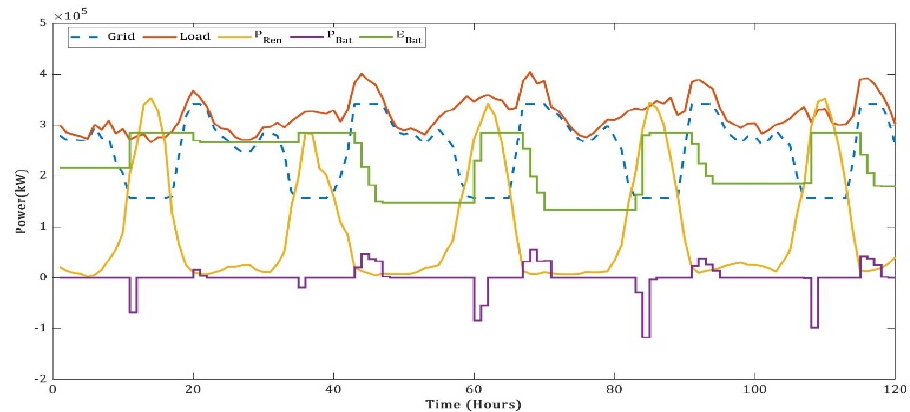
Figure 14. Power distribution with ALA-QPSO for the minimum LPSP for 21–26 June.